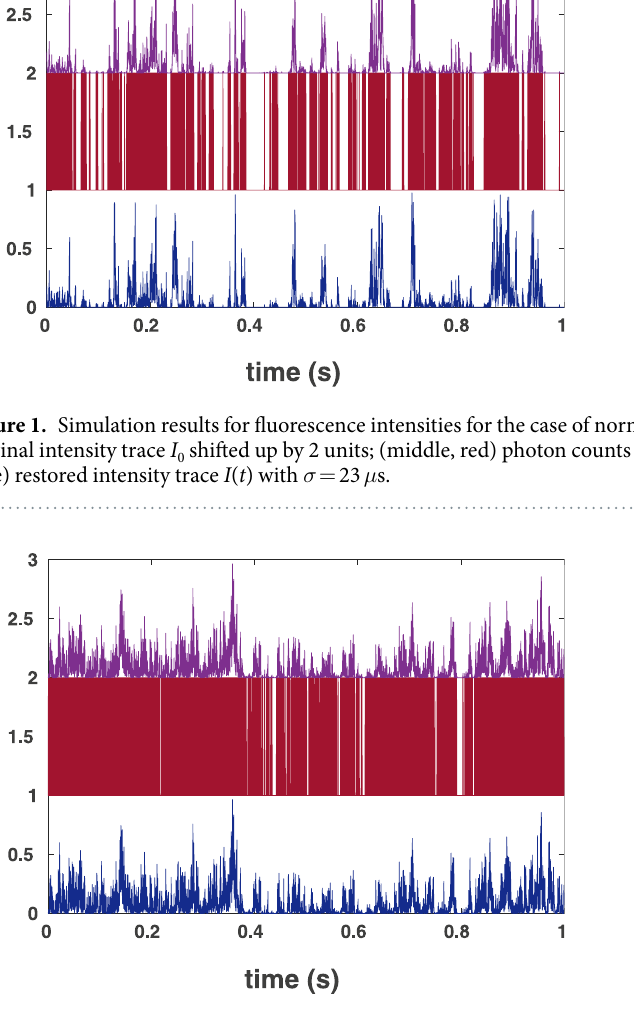
Figure 2. Simulation results for fluorescence intensities for the case of anomalous diffusion: (upper, purple) the original intensity I 0 shifted up by 2 units; (middle, red) photon counts ( I p ) shifted up by 1 unit, and (lower, blue) restored intensity trace I ( t ) with σ = 12 μ